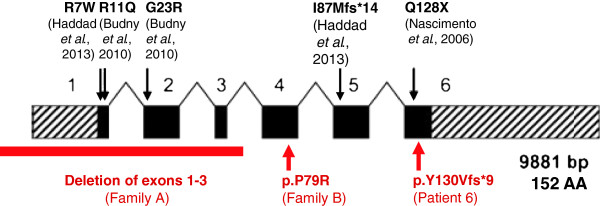
Scheme of the
UBE2A
gene, showing the position of the newly identified (in red, below) and previously published mutations (in black, above; modified after [4]).